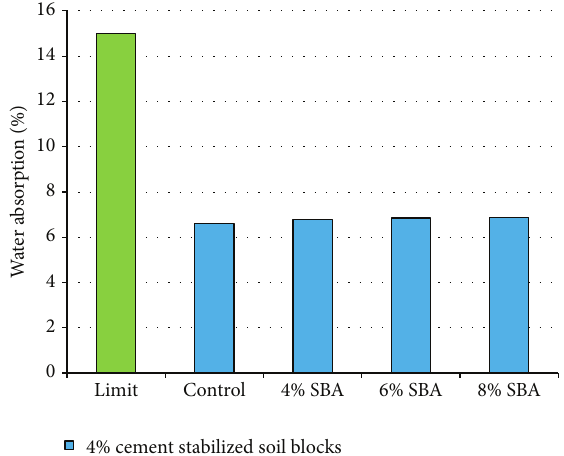
Figure 7: Water absorption levels of 4% cement stabilized blocks admixed with